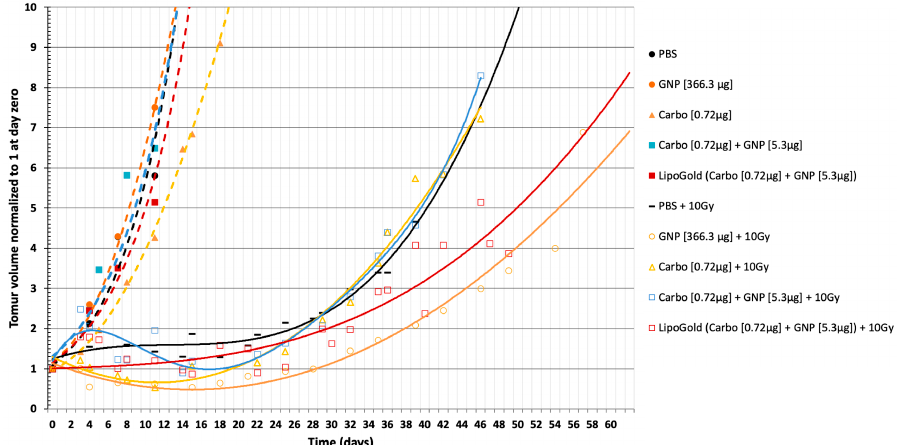
Figure 2. Tumor growth delay for di ff erent treatments of Nu / Nu nude mice bearing a subcutaneous HCT116 colorectal cancer cell line. The data passing through the pink horizontal strike-through trace at 5IT ± 0.2 are reported in Figure 3.